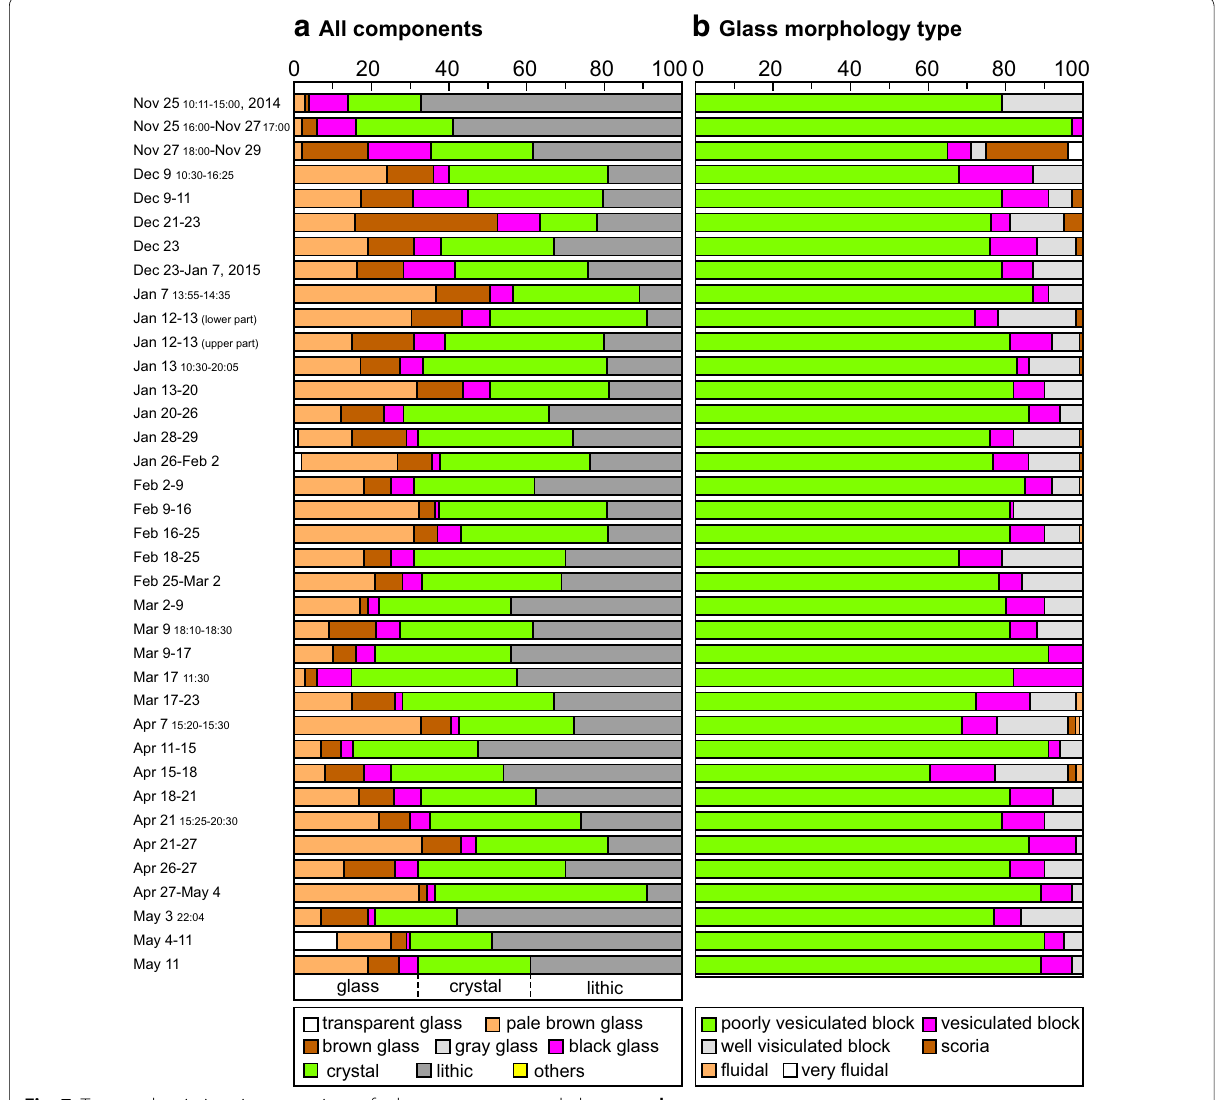
Fig. 7 Temporal variations in proportions of ash components a and glass types